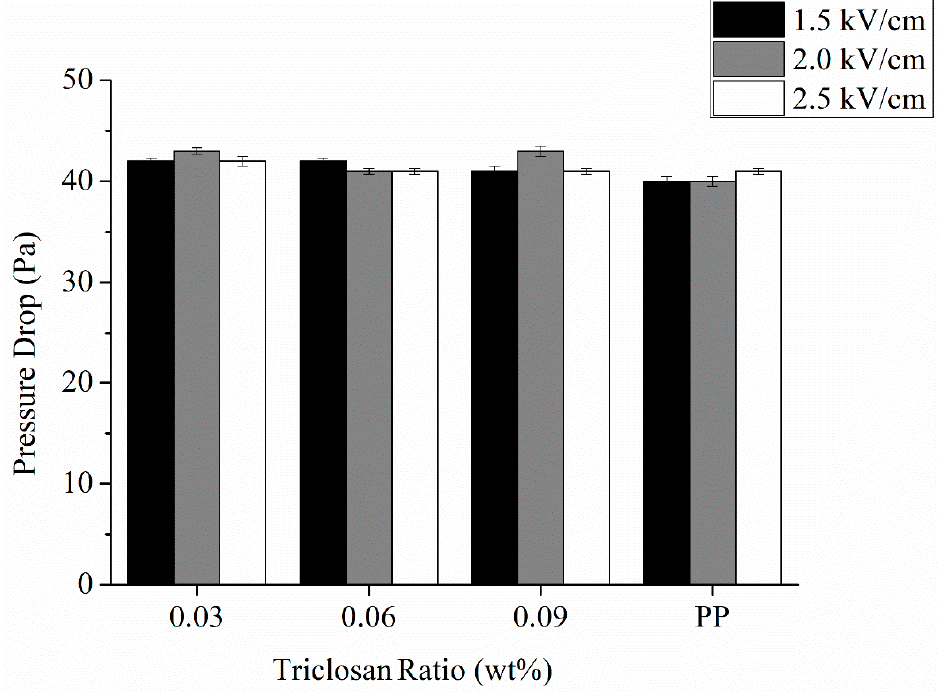
Figure 6. Pressure drop of antibacterial electret PP filters as related to triclosan amount (0.03, 0.06, and 0.09 wt%) and electric field intensity (1.5, 2.0, and 2.5 kV/cm). The control group (electret pure PP nonwoven fabrics) contains 0 wt% of triclosan. Table 3. Effects of triclosan amount over the physical properties of antibacterial electret PP filters.